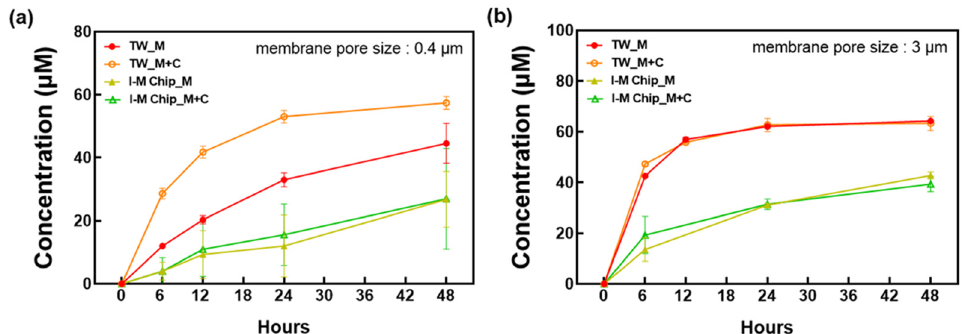
Figure 5. After culturing RPTEC and HUVEC on a TW and I-M chip for 14 days, metformin (100 μ M) alone or metformin (100 μ M) and cimetidine (0.5 mM) were treated with metformin secretion concentration after 6, 12, 24, and 48 h evaluated via HPLC. The difference between static TW and fluidic chip according to membrane pore size of ( a ) 0.4 μ m and ( b ) 3 μ m were compared. TW, C: culture method, R + H: RPTEC and HUVEC culture.